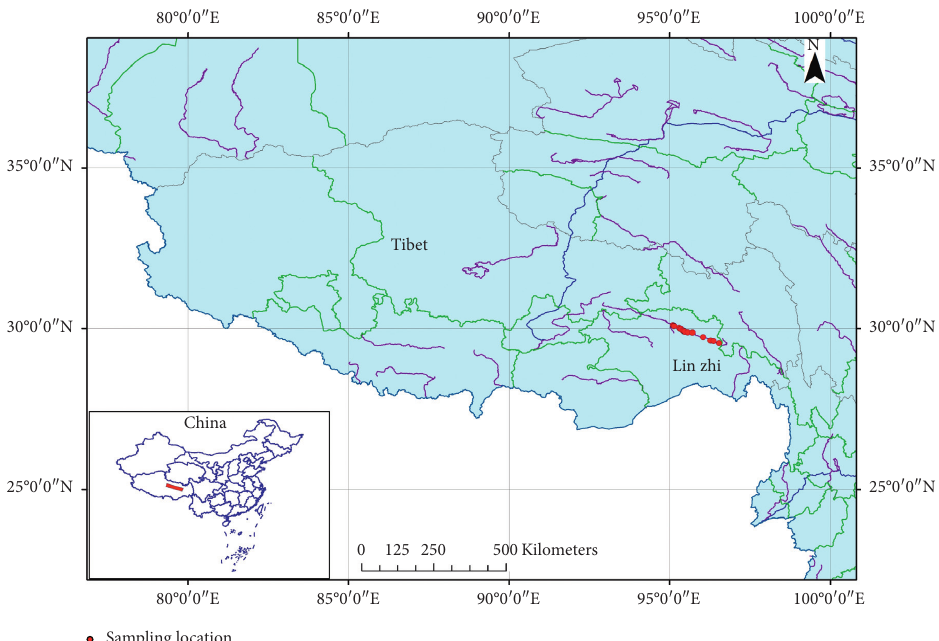
Figure 1: Sampling